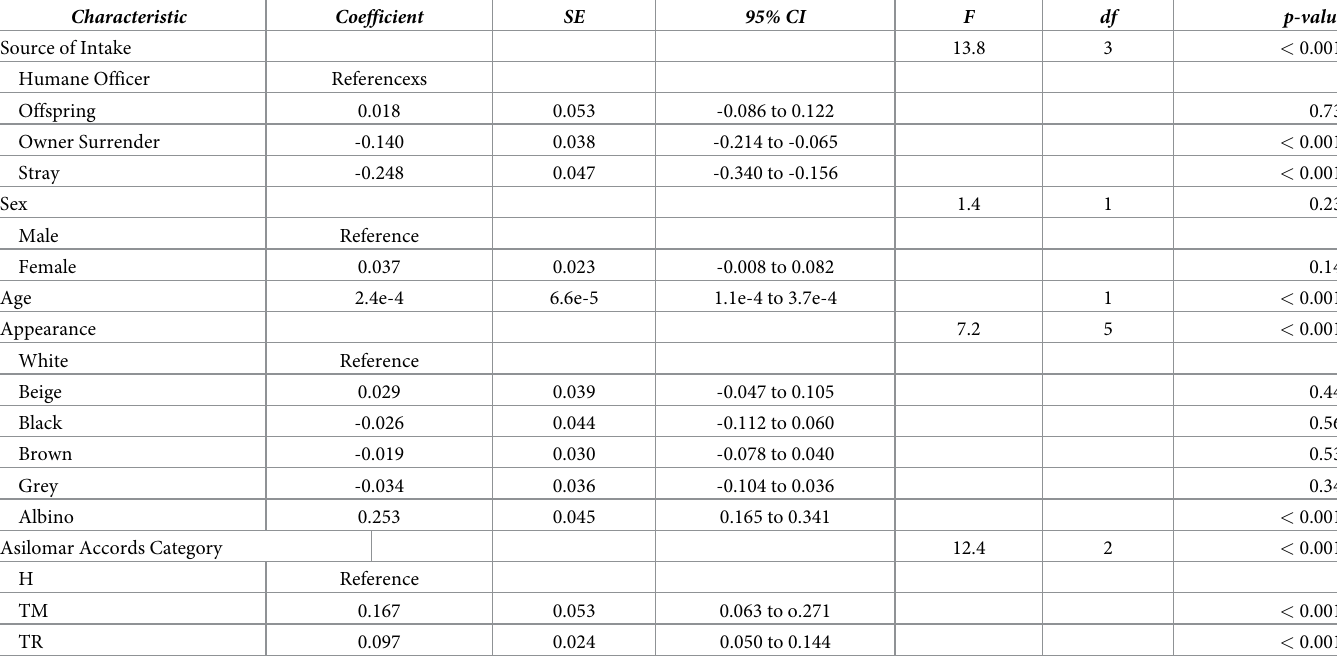
Table 7. Multiple linear regression model predicting log LOS by characteristics of rats (N = 1,479).